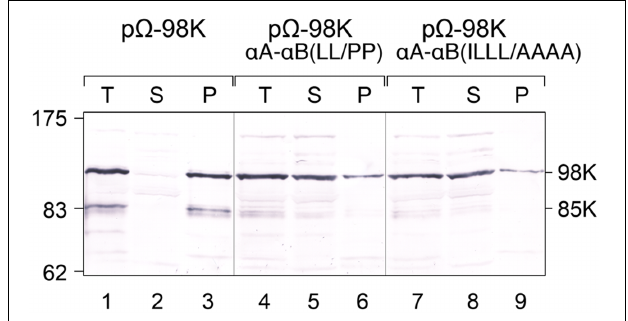
FIGURE 7 | Impact of the structure and amphipathic property of CTD α -helices on membrane association of 98K in vivo. Arabidopsis protoplasts were transfected with the expression plasmids p (cid:127) -98K, p (cid:127) -98K- α A- α B(LL/PP) or p (cid:127) -98K- α A- α B(ILLL/AAAA) as indicated. The cells were harvested 24 hpt and were lyzed to generate a total protein fraction (T). Soluble (S) and insoluble pellet (P) fractions were then separated by centrifugation, and samples of each fraction corresponding to equal amount of fresh tissue were subjected to 8% SDS-PAGE and immunoblot analysis using anti-98K antiserum. Molecular mass markers (Biolabs) are indicated on the left, whereas positions of the viral proteins 98K and 85K are indicated on the